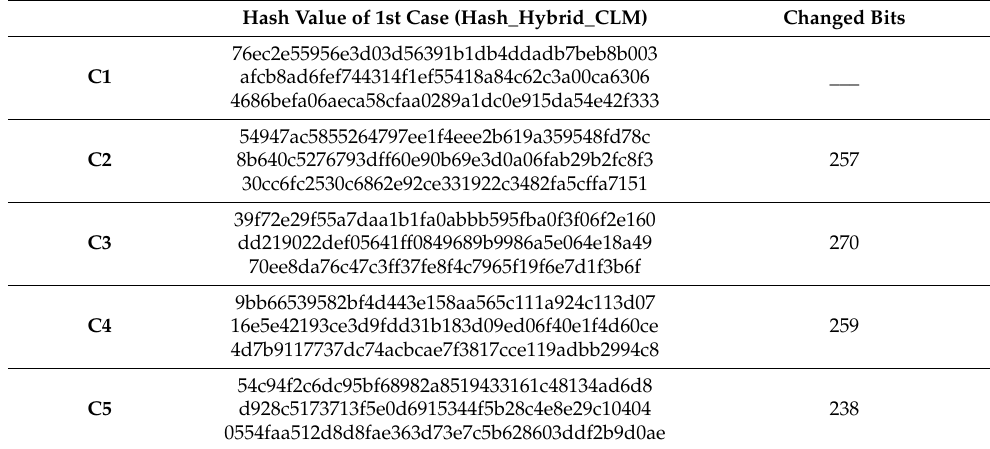
Table 4. Hash values of first structure.